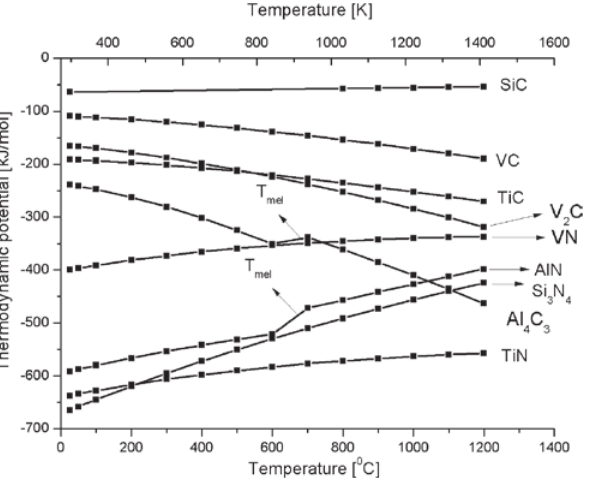
Fig. 4: Temperature dependence of thermodynamic potential for compounds forming in the C-N-Si-Ti-Al-V system (calculated on the basis of thermodynamic data [10]).